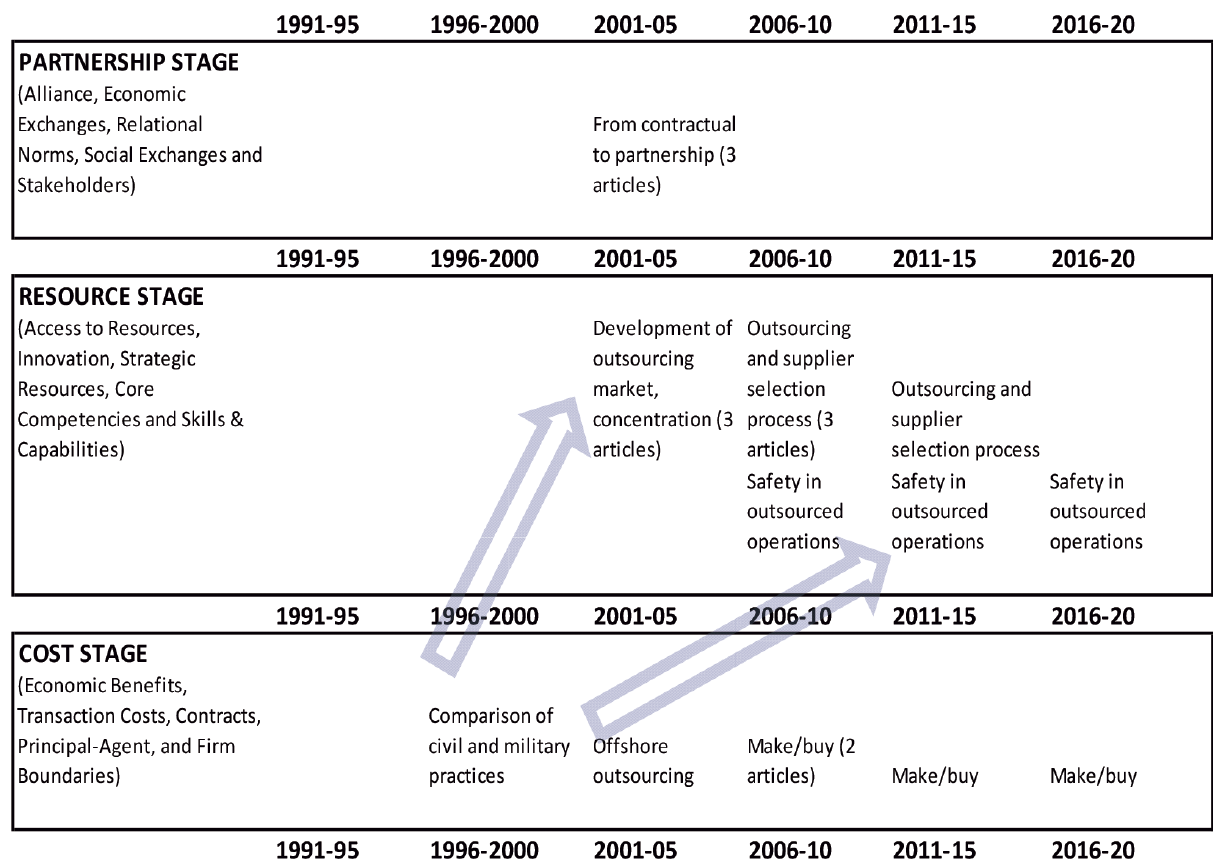
Figure 2. Development of the MRO outsourcing research